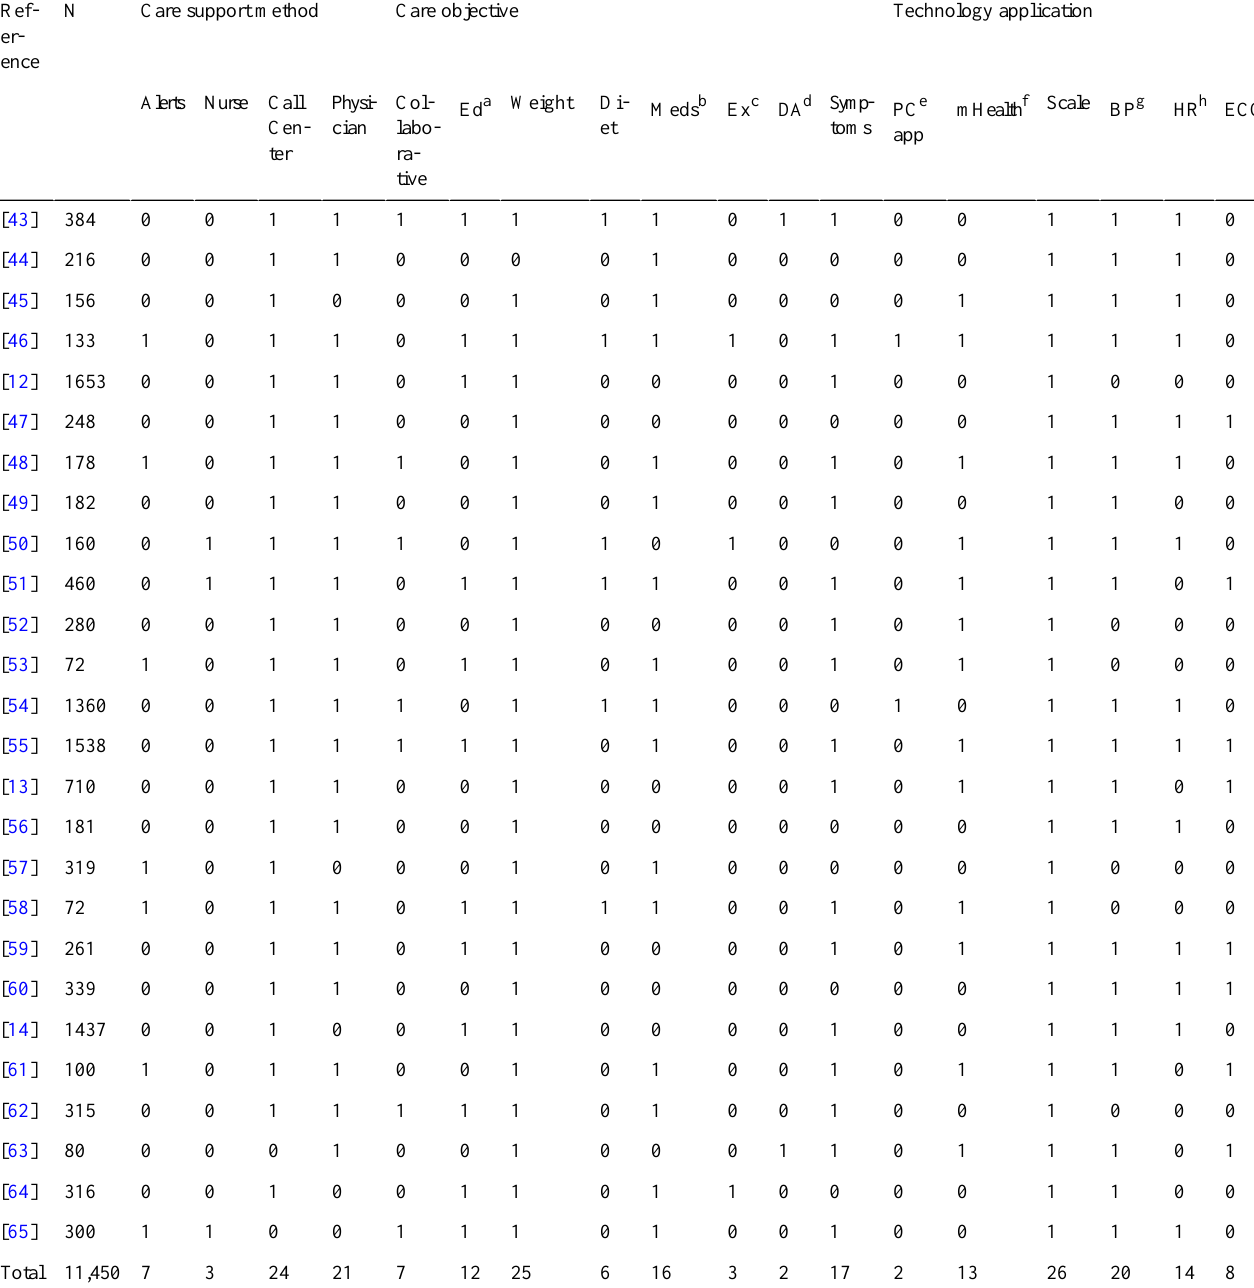
Table 3. Telemonitoring strategies and randomized controlled trials included in the meta-analysis.